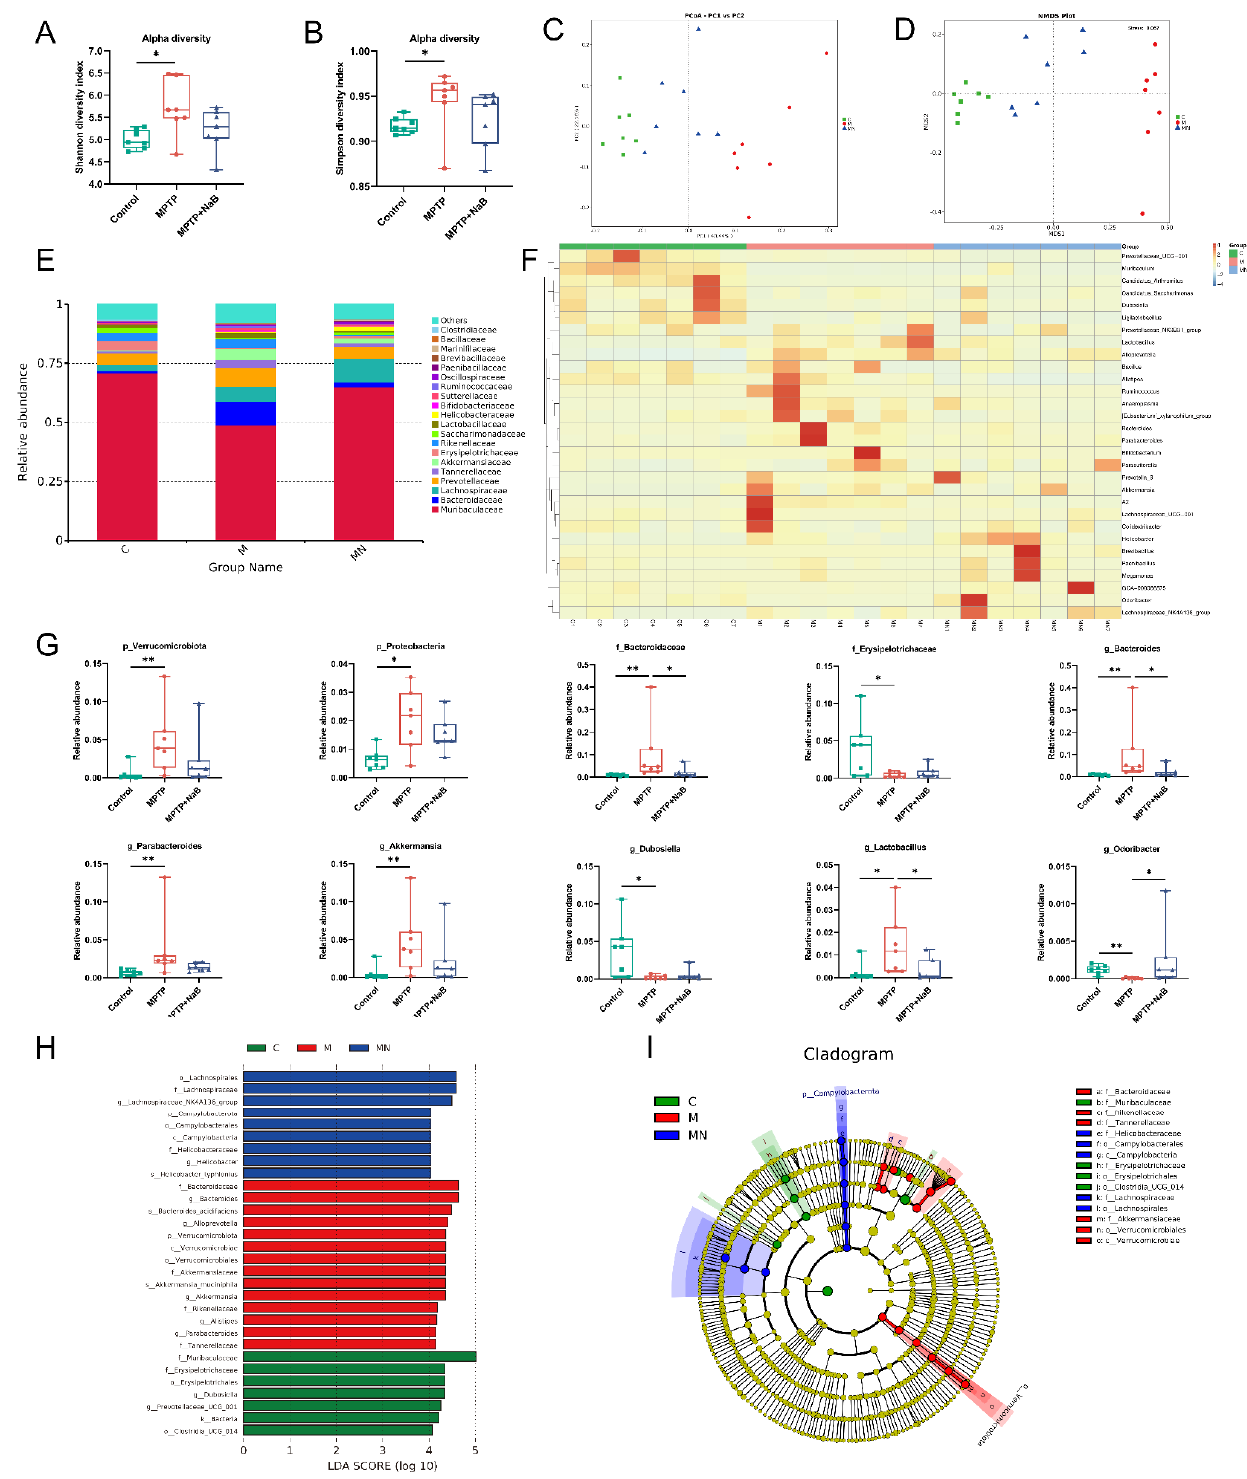
Figure 5. Sodium butyrate (NaB) alters gut microbiome dysbiosis in 1-methyl-4-phenyl-1,2,3,6- tetrahydropyridine (MPTP)-induced Parkinson’s disease (PD) mice. α -diversity indexes of gut